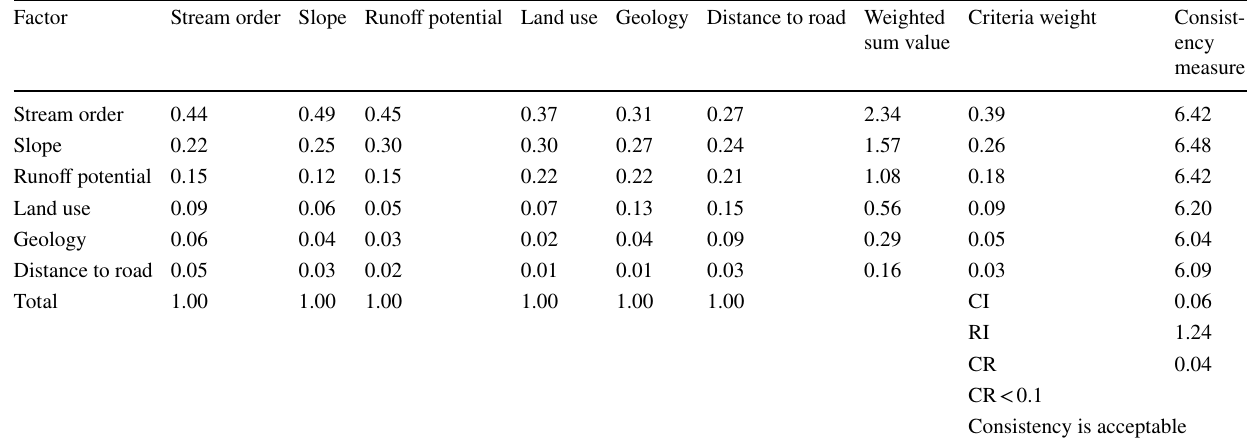
Table 11 Determined consistency ratios (CR)